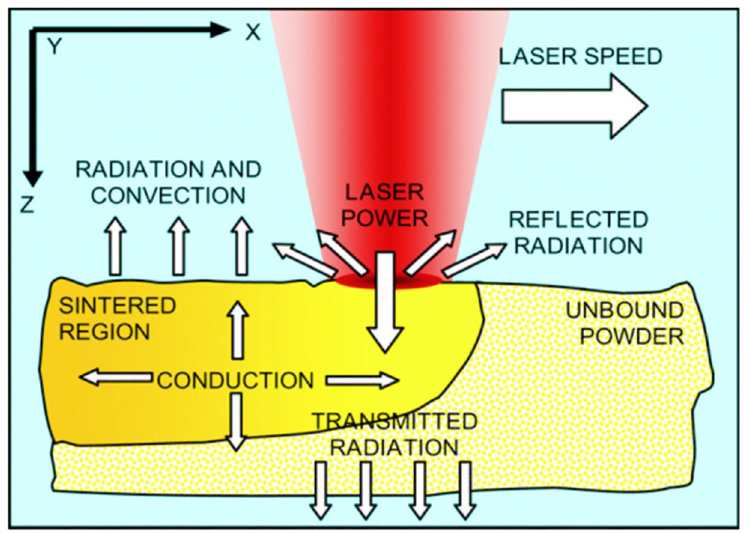
Figure 11. Schematic representation of energy-transfer phenomena occurring in SLS. Adapted from [98].